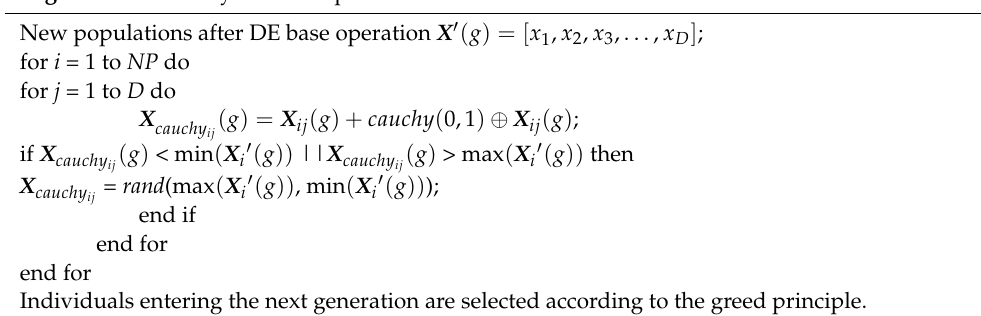
Algorithm 3 . Cauchy mutation